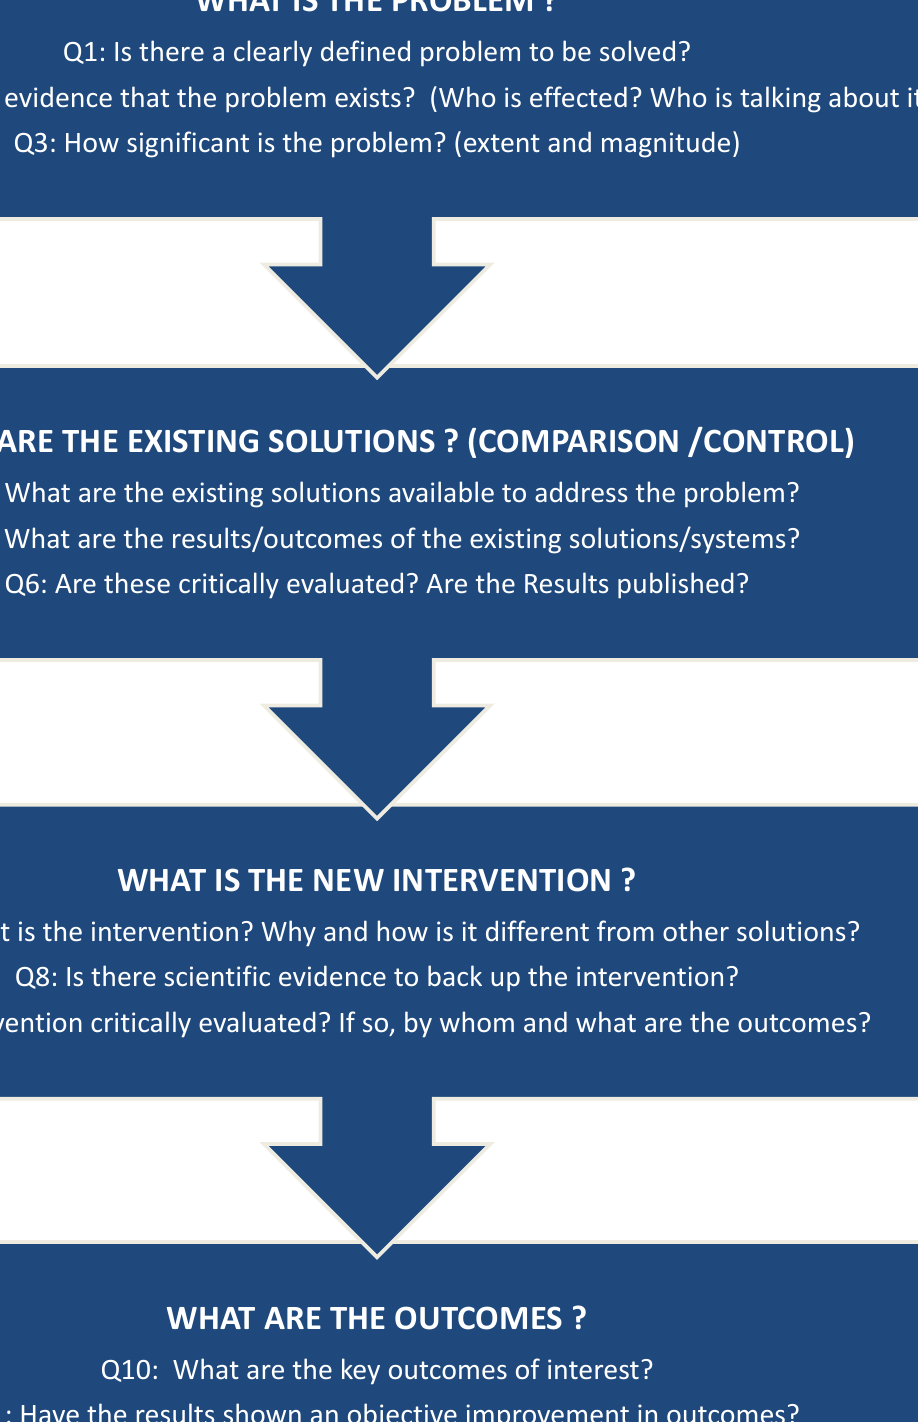
Figure 12: Evidence Assessment Framework for Blockchain